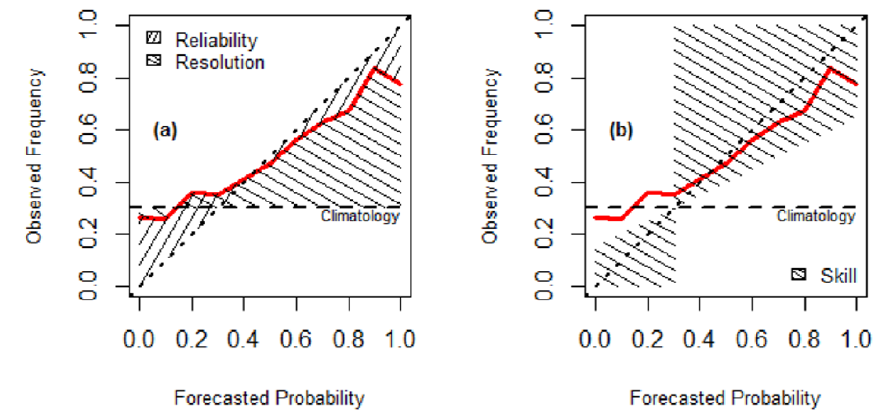
Figure 6. Theory behind Brier skill score illustrated for an imaginary forecast (red line): (a) reliability and resolution, (b) skill. In (a) , the area representing reliability should be as small as possible and for resolution as large as possible. The forecast has skill (BSS > 0), i.e., performs better than the reference forecast, if it is inside the shaded area in (b) . Ideally, the forecast would follow the diagonal (BSS = 1) (adapted from Hsu and Murphy, 1986; Wilson,